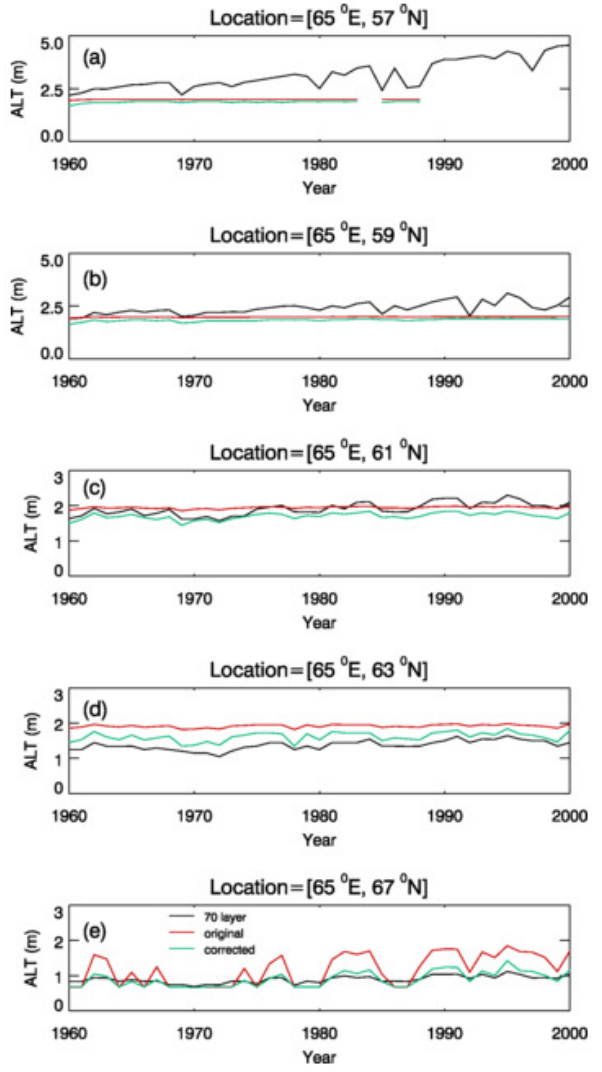
Figure 2. The simulated active layer thicknesses for a selected south-north transect at 65 ° E. The 70-layer simulated active layer is shown (in black) along with the original 4-layer active layer (in red) and the corrected 4-layer active layer (in green). Note difference in scale between Figures 2a and b and Figures 2c-e.